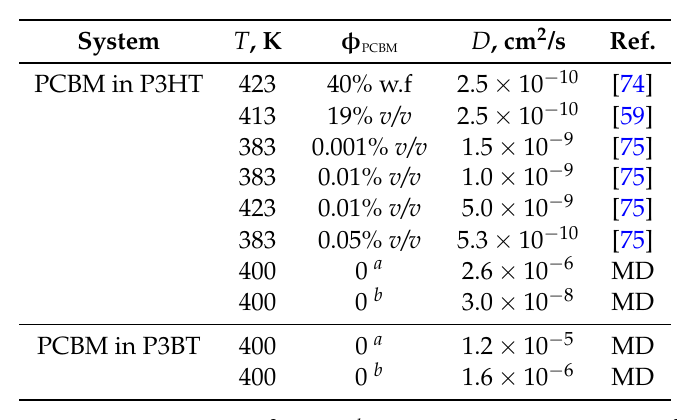
and estimated in the present study PCBM = 0 means infinite PCBM